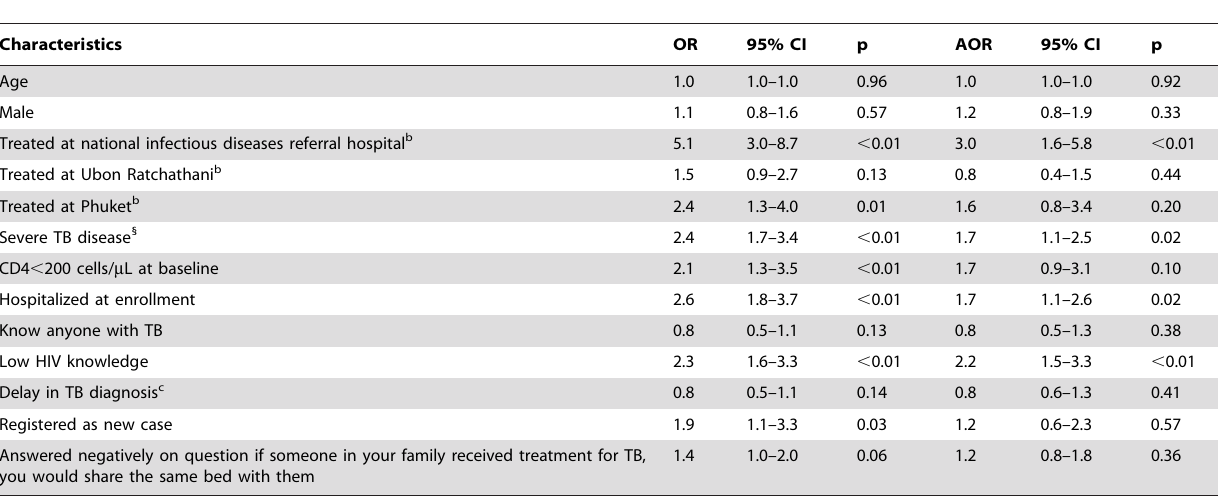
Table 4. Bivariable and multiple logistic regression analyses of predictors for having low TB knowledge a among HIV-infected TB